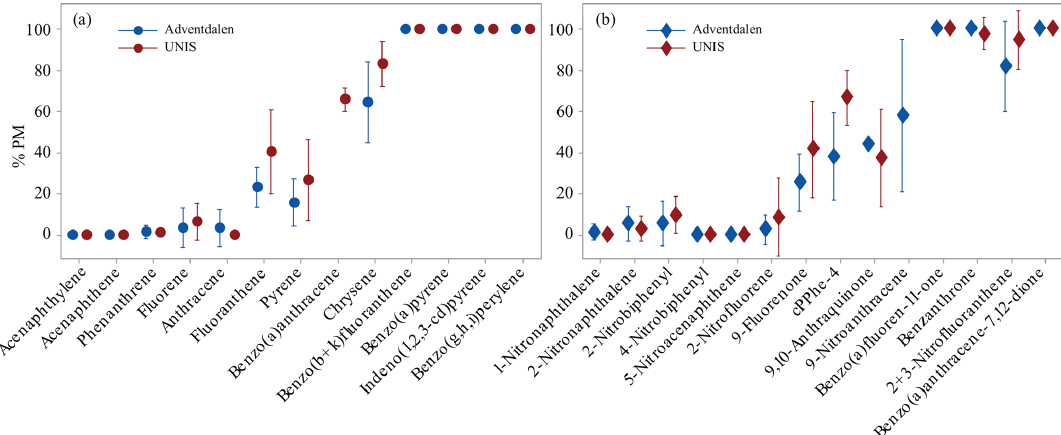
Figure 3. Percentage of (a) PAHs and (b) nitro- and oxy-PAHs determined in particulate phase (% PM) at UNIS ( n = 6) and Adventdalen ( n = 6); individual standard deviations are used to calculate the